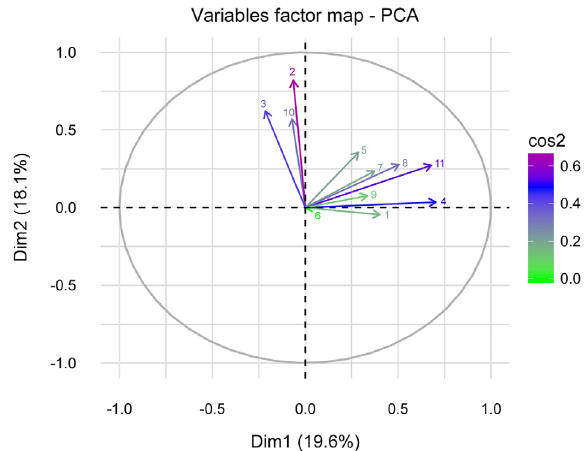
Figure 1. Principal component analysis of variables (PCA). The factor map helps to visualize the cluster of correlated variables in groups ( ffi 90 (cid:3) ). Cos2 is the gradient of quality to highlight the most important variables in explaining the variations retained by the principal components. Dimension 1 and 2 (Dim1 and 2) is the space where variables are expressed (<38% of variance). The distribution of the surveyed population through variables is also observed. Variables analyzed: (1) sex, (2) weight, (3) age, (4) number of animal per household, (5) veterinary attention, (6) type of dwelling, (7) access to green areas, (8) drinking water, (9) disease informa- tion, (10) prevalence, and (11) region.